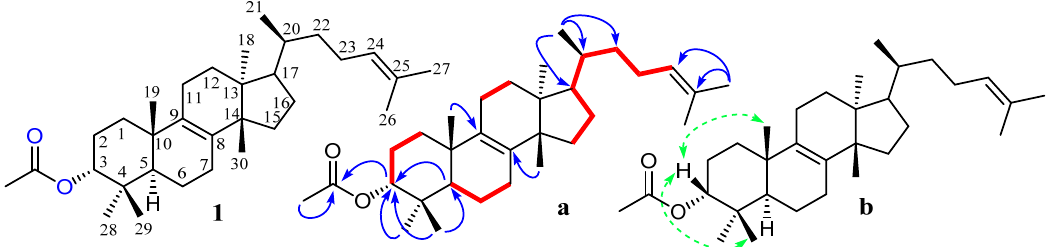
Figure 2. Structure of the compound 1 ; ( a ) key heteronuclear multiple bond correlation HMBC (blue arrow) and H ▬ H COSY (red line) correlations ; ( b ) key nuclear overhauser effect spectroscopy NOESY correlations of compound 1 .